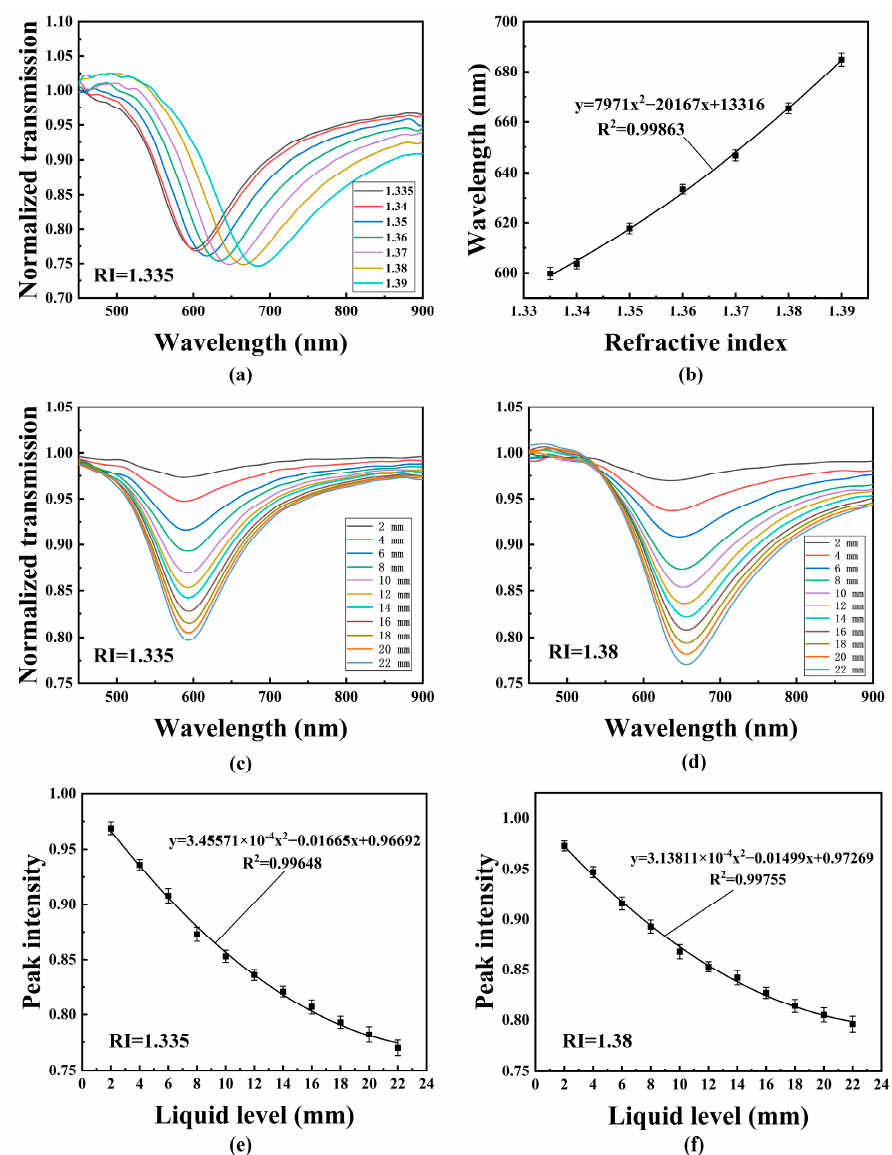
Figure 7. The sensing performance of the POF probe with polished depth of 100 µ m: ( a ) The transmission spectrum for RI measurement; ( b ) The relationship between RI and SPR peak wavelength; The transmission spectrum for liquid level measurement with RI of 1.335 ( c ) and 1.38 ( d ); The relationship between liquid level and SPR peak intensity with RI of 1.335 ( e ) and 1.38 ( f ).